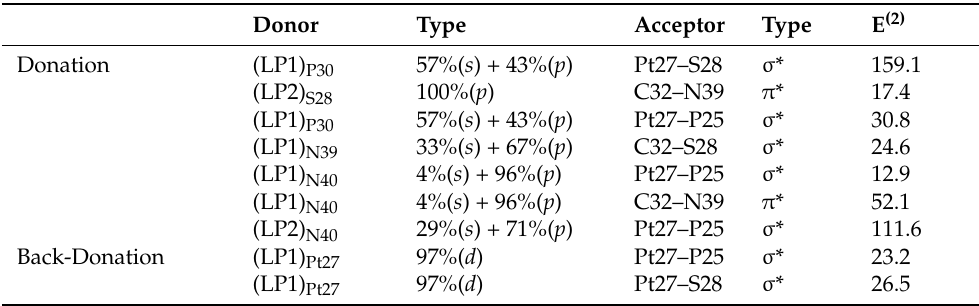
Table 7. Second-order perturbation energies (E (2) ) for charge transfers from donor to acceptor orbitals in Pt(BPT)(dppe)] ( 1 ).